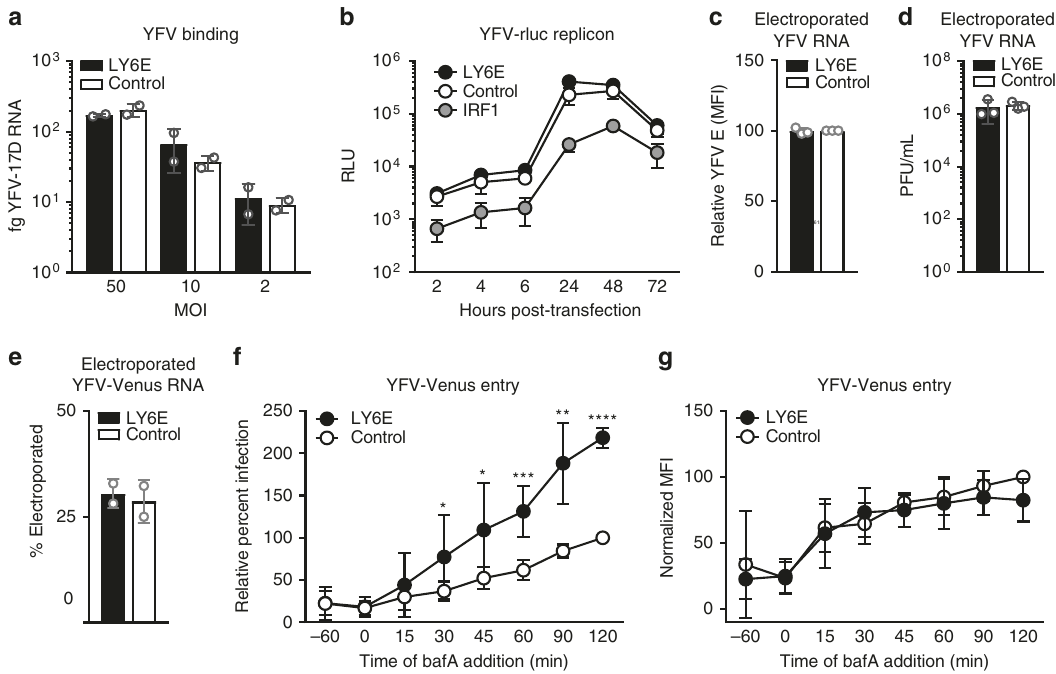
Fig. 4 LY6E enhances entry of yellow fever virus. a STAT1 -/- fi broblasts transduced with lentivirus expressing LY6E or an empty vector control were incubated with 50, 10, or 2 MOI YFV-17D at 4 °C for 1 h then harvested for qRT-PCR. n = 2 biological replicates. b STAT1 -/- fi broblasts transduced with lentivirus expressing LY6E, IRF1, or a fl uc control were transfected with YFV-17D-rluc replicon RNA. Lysates were assayed for Renilla luciferase activity at the indicated time points. Relative light units (RLU) are shown. n = 3 biological replicates. c STAT1 -/- fi broblasts transduced with lentivirus expressing